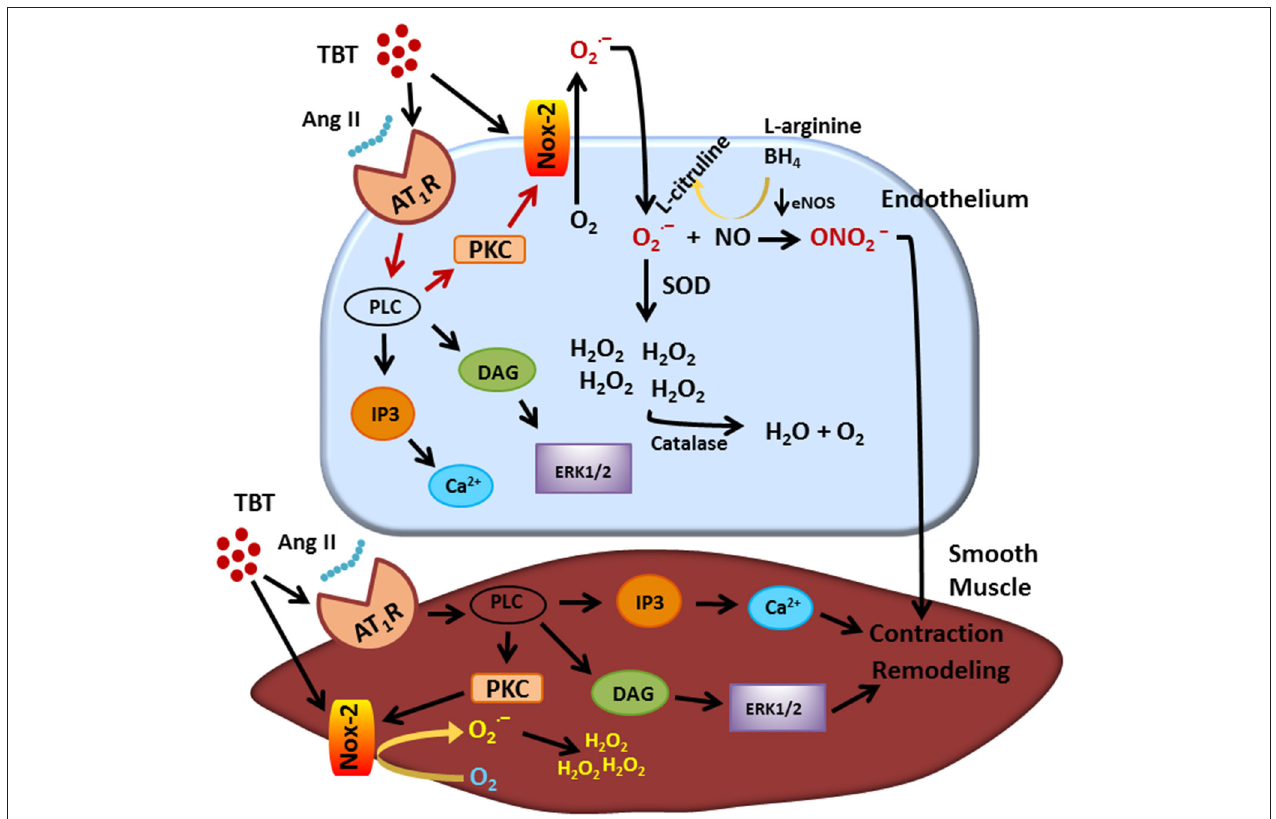
FIGURE 1 | Visual abstract showing the main actions of TBT on endothelial and smooth muscle cell. TBT,